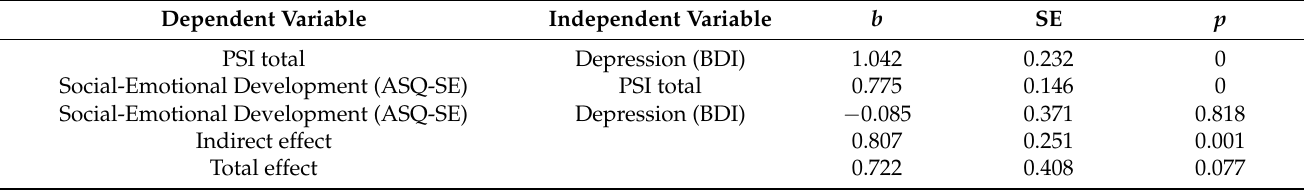
Table 5. Mediation